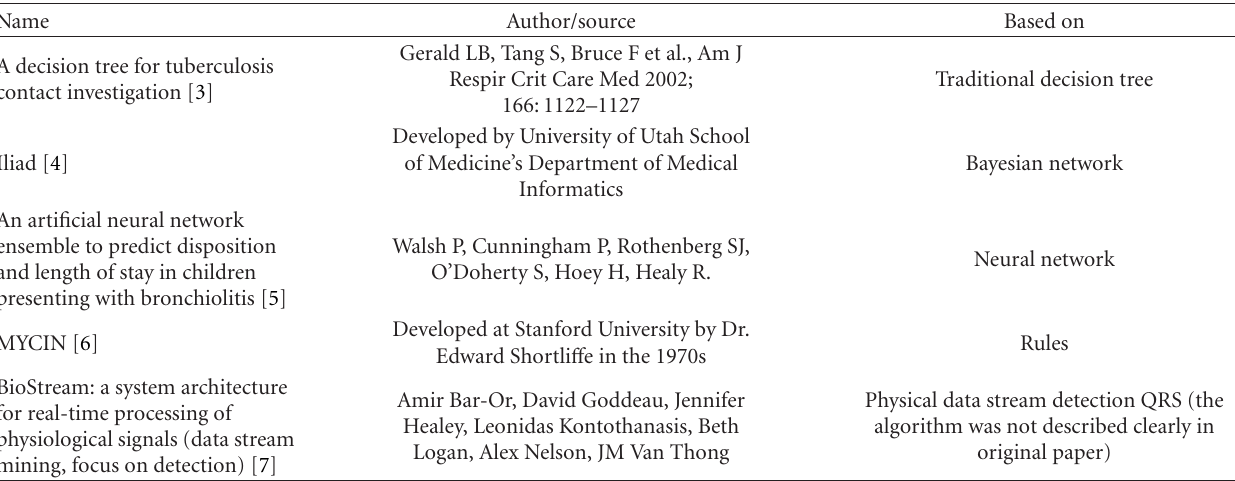
Table 1: Existing clinical decision support systems.